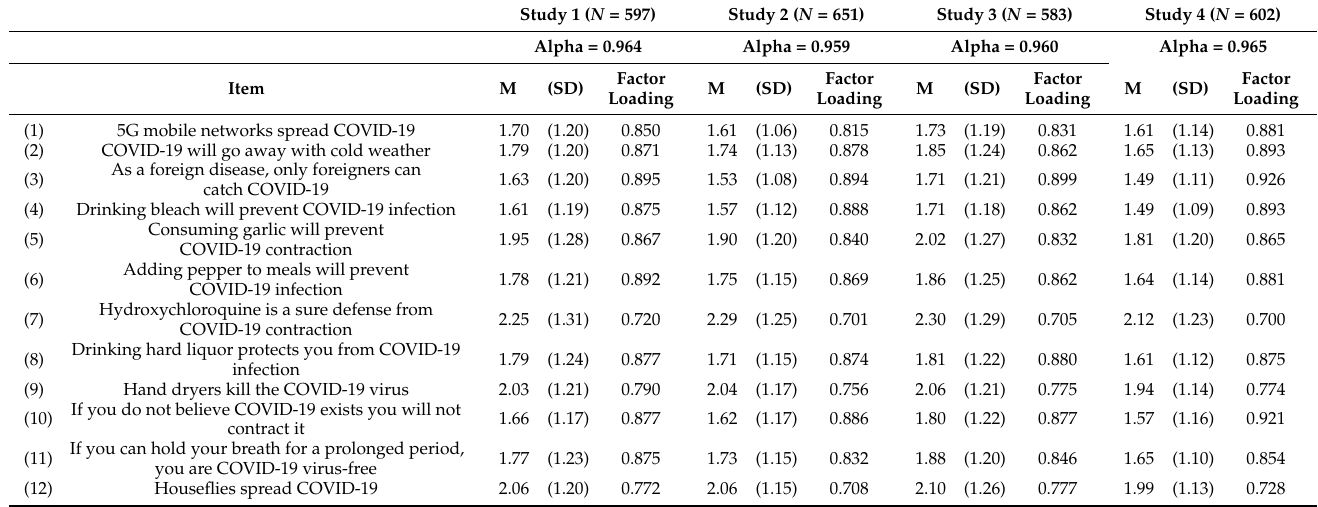
Table 2. Item-factor loadings and item-level descriptive statistics for COVID-19 transmission misinformation scale